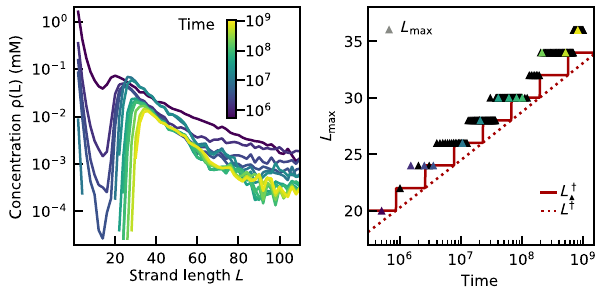
FIG. 12. Transient strand distributions. Left: temporal develop- ment of the length distribution in a closed system. Over time the concentration of short strands decreases and the minimum develops into depleted region. Right: the position of the maxi- mum L shifts logarithmically with time toward longer max